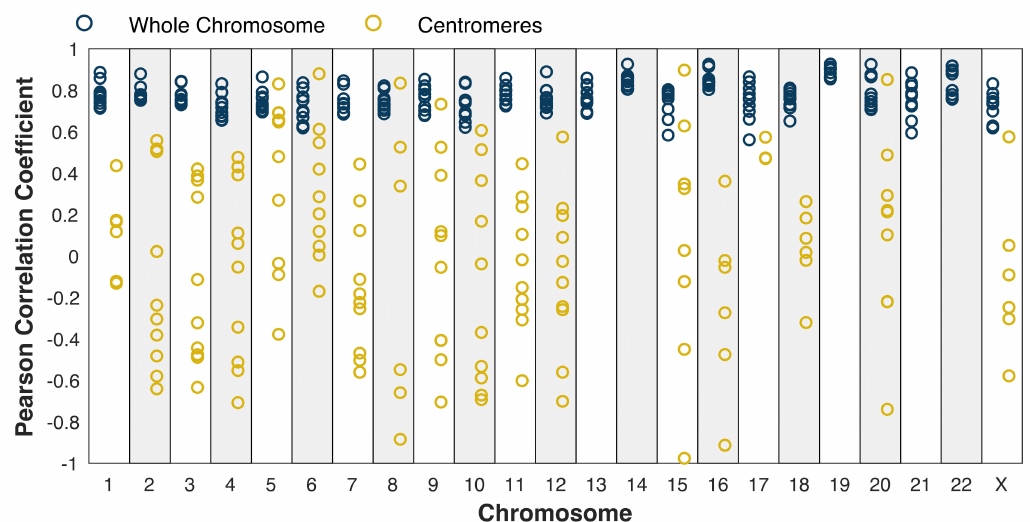
Figure 3. Centromere replication timing is more variable between cell lines than chromosome-wide replication timing. Blue: whole chromosome (excluding centromere); gold: centromeres. Pearson correlation was calculated for each mappable centromere (see Figure 1) and for each chromosome for each pair of cell lines. Dots represent individual pairwise comparisons. The difference in the distribution of correlation coefficients between the centromeres and whole chromosomes is robust when controlling for the size of the centromeres (Figure S5).